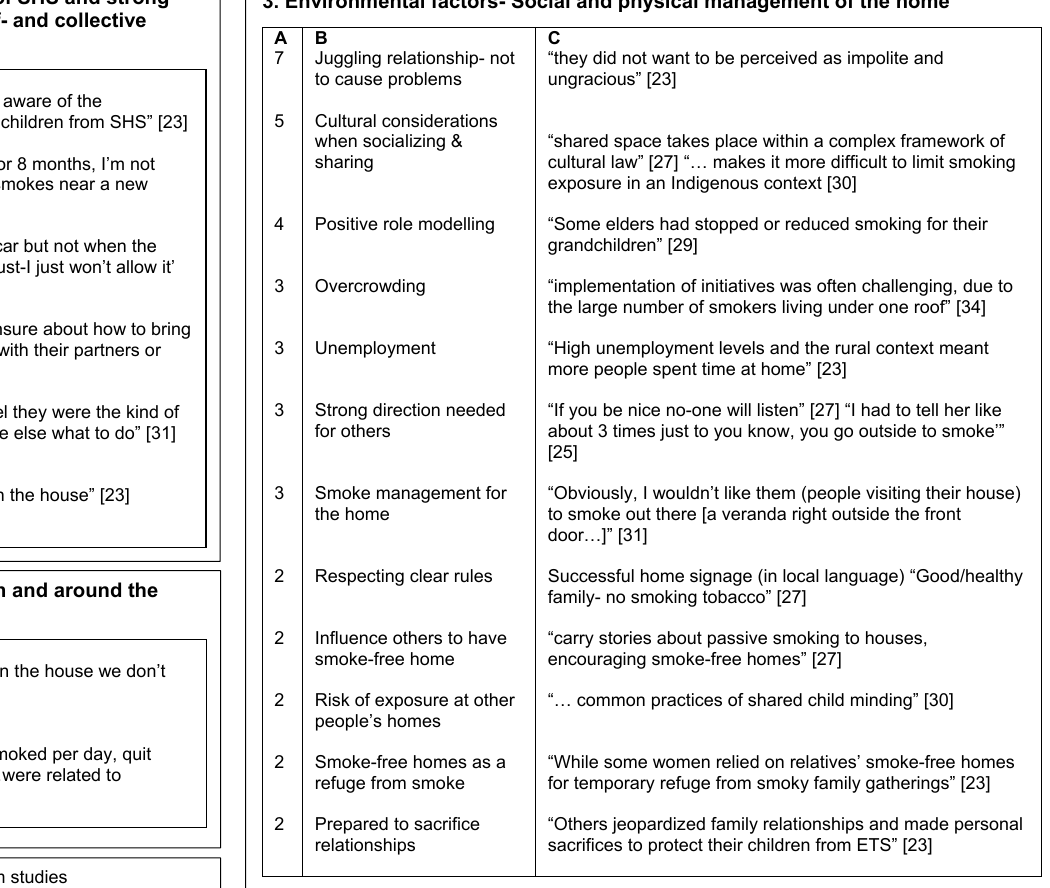
Figure 2 . Indigenous specific themes arranged into the three reciprocal determinism factors of the Social Cognitive Theory from the 15 included studies.